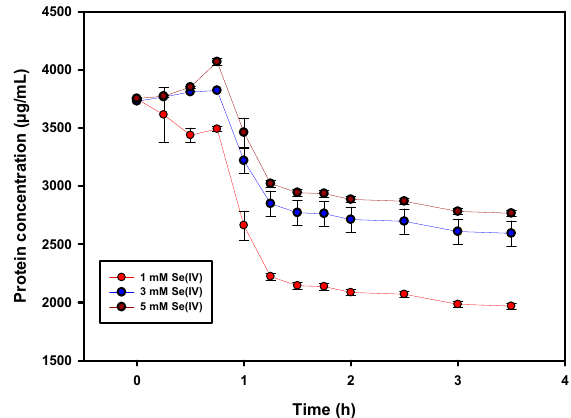
Figure 8. Protein variation across the 1, 3 and 5 mM SeO 32 − concentrations.